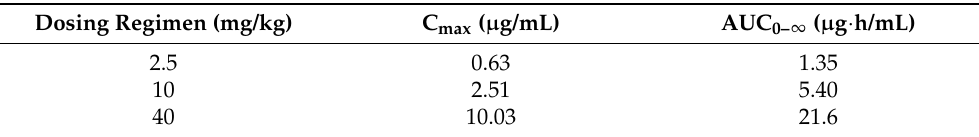
Figure 1. Pharmacokinetic parameters of pazufloxacin after single subcutaneous administration in infected neutropenic mice. Simulation time-concentration curves were created following parameters. Vd = 0.84 L/kg, ke = 2.40 h –1 , and ka = 0.96 h –1 . Data are expressed as mean ± S.D. (n = 3). Table 1. Pharmacokinetic parameters of pazufloxacin after single subcutaneous doses of 2.5, 10 and 40